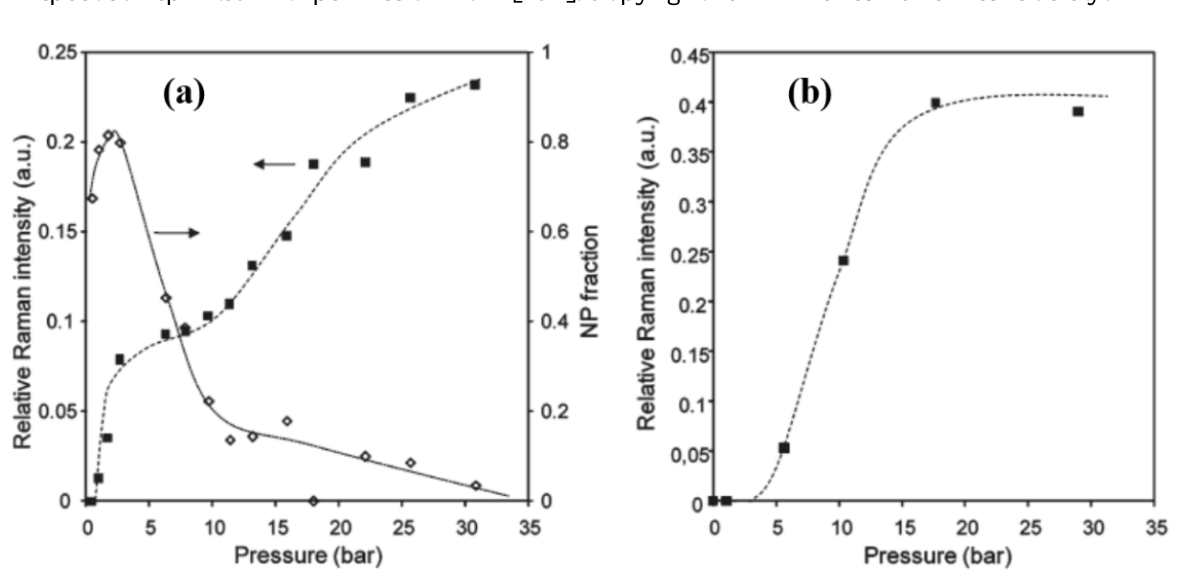
Figure 33. CO adsorption isotherms at 303 K. ( a ) MIL-47(V III ); ( b ) MIL-47(V IV ). 2 Symbols: ■—adsorbed CO ; ◊—fraction of narrow pores in MOF determined by Raman 2 spectra. Reprinted with permission from [161]. Copyright 2011 American Chemical